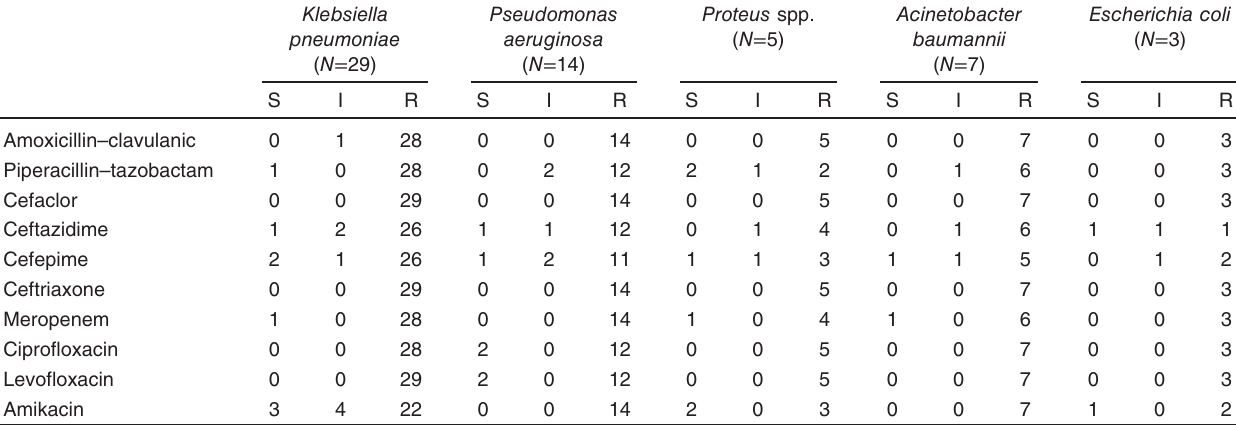
Table 3 Sensitivity of the organisms to first group of